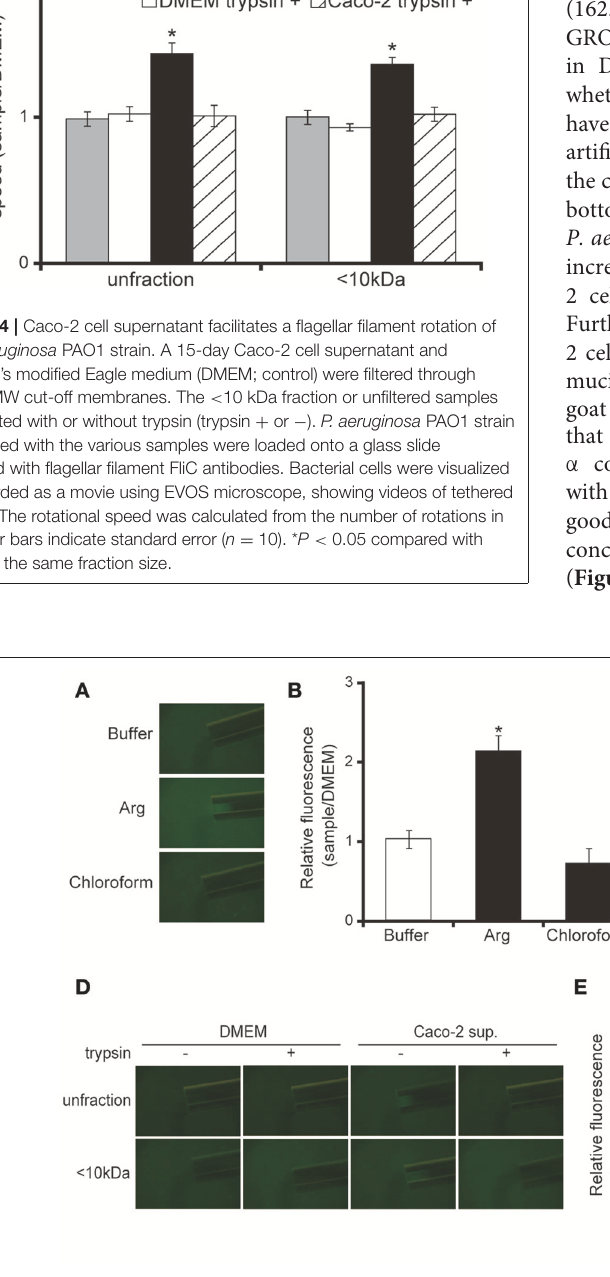
FIGURE 5 | Caco-2 cell supernatant attracts the P. aeruginosa PAO1 strain. (A) A glass slide surface was filled with a P. aeruginosa PAO1 strain expressing a green fluorescent protein (GFP). Capillary tubes were filled with buffer (control), Arg (attractant), or chloroform (repellent). The accumulation of the P. aeruginosa PAO1 strain expressing GFP at the capillary tip was visualized and photographed by microscopy at a magnification of 40 × . (B) The graph shows the relative intensity of GFP in the capillary after incubation for 10 min. Error bars indicate standard error ( n = 3). * P < 0.05 compared with buffer. (C) A buffer (control), Arg (attractant), or chloroform (repellent) filled the bottom chamber of Transwell. The P. aeruginosa PAO1 strain was added and, after 3 h, the numbers of bacteria in the bottom chambers were counted. Error bars indicate standard error ( n = 3). * P < 0.05 compared with buffer. (D) A 15-day Caco-2 cell supernatant and Dulbecco’s modified Eagle medium (DMEM; control) were filtered through 10-kDa MW cut-off membranes. The < 10 kDa fraction or unfiltered samples were treated with or without trypsin (trypsin + or − ). A cover glass surface was filled with the P. aeruginosa PAO1 strain expressing GFP. Capillary tubes were filled with the treated samples. The accumulation of the GFP-expressing P. aeruginosa PAO1 strain at the capillary tip was visualized and photographed by microscopy at a magnification of 40 × . (E) The graph shows the relative intensity of GFP in the capillary tube after incubation for 10 min. Error bars indicate standard error ( n = 3). * P < 0.05 compared with DMEM of the same fraction